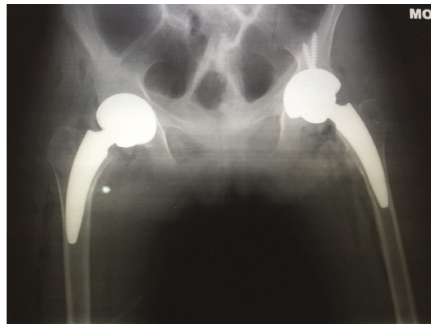
Figure 5: Postoperative plain radiograph of bipolar short-stemmed total hip replacements.